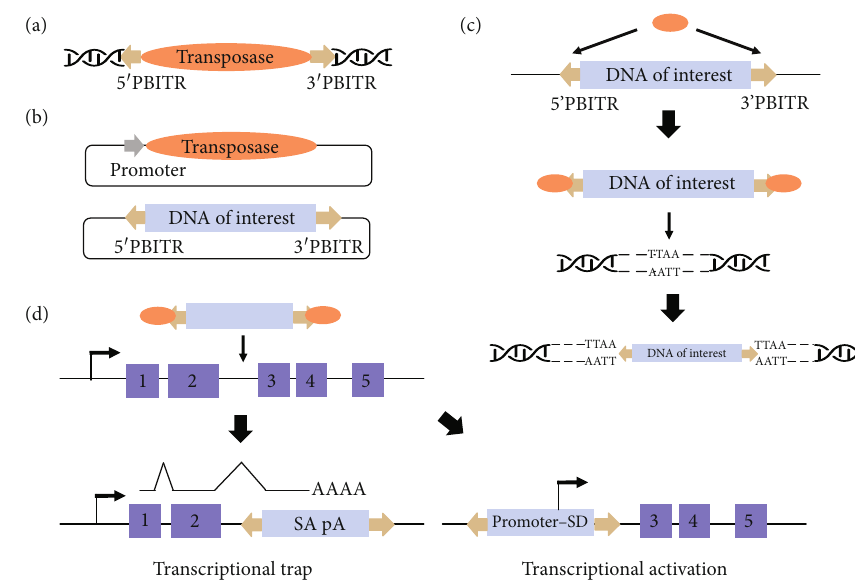
Figure 1: The piggyBac ( PB ) transposon System. (a) The original PB elements consist of the transposase gene (orange) and inverted terminal repeats (ITRs, yellow arrows). (b) A binary transposition system for gene delivery in plasmids. One is a transposase expression helper plasmid driven by a promoter (grey arrow), and the other is a donor plasmid that contains a DNA sequence of interest (light purple) and/or drug selection marker fl anked by ITRs. (c) Vector-to-chromosome transposition. After cotransfection of the binary system in vitro or in vivo, the transposon carrying a transgene is excised from the donor plasmid and then integrated into the chromosome via transposase interaction with host genome sites containing TTAA segments. (d) Insertion of transposons can disrupt or promote gene expression. In the example shown in this fi gure, a transposon is integrated between exons 2 and 3 (numbered purple), which may lead to two possible outcomes: (1) the transposon hijacks transcription via the splicing receptor-polyadenylate signaling (SA-ployA) element, disrupting gene function and leading to the trap of transcript expression (exons 1 – 2), and (2) the transposon drives the expression of downstream gene sequences (exons 3 – 5) via the promoter-splicing donor (SD)